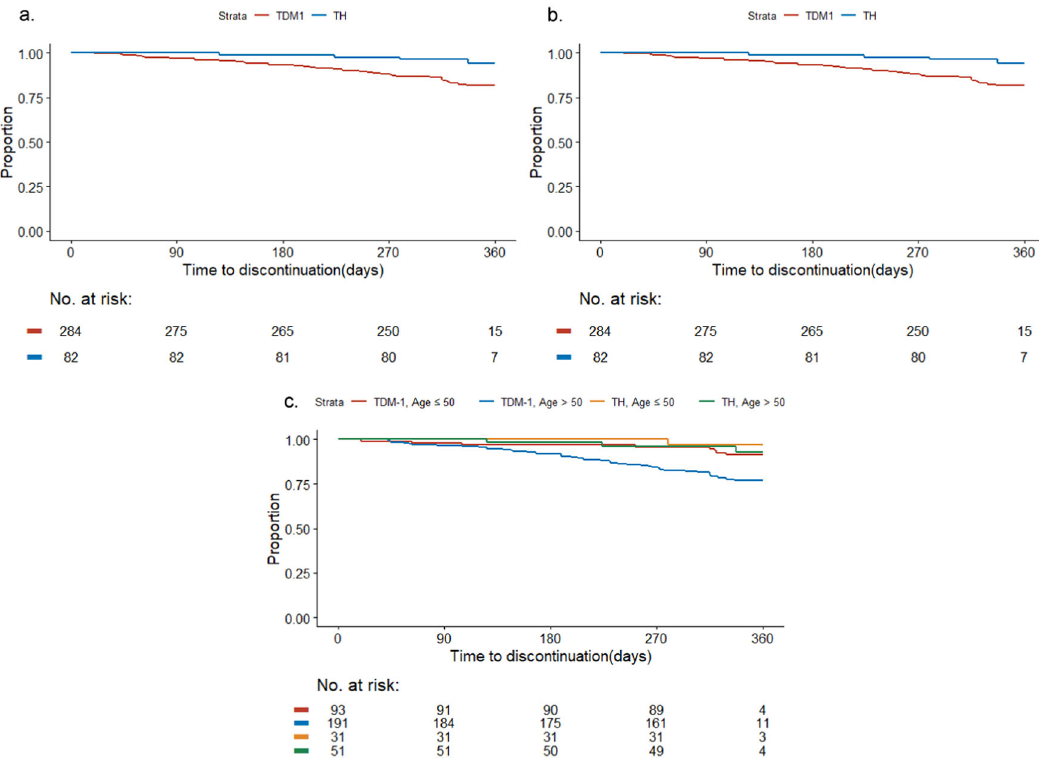
Fig. 2 Time to discontinuation by age groups and arms. a Shows the time to discontinuation by age group ( p = 0.002); b shows the time to early discontinuation by arm ( p = 0.007); and c shows the time to early discontinuation by age group and arm ( p <